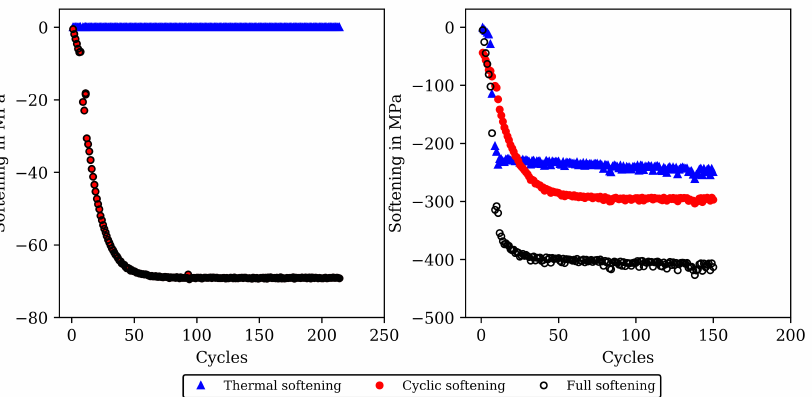
Figure 13. Softening that is lost by the different softening proportions (thermal softening, cyclic softening, and full softening) of the viscoplasticity model from step 2. The softening proportions are subtracted from the model results of stress at the load reversal points without softening. The results are presented for 20 ◦ C ( left ) and for 650 ◦ C ( right ), both for the CLCF-tests for the HT0